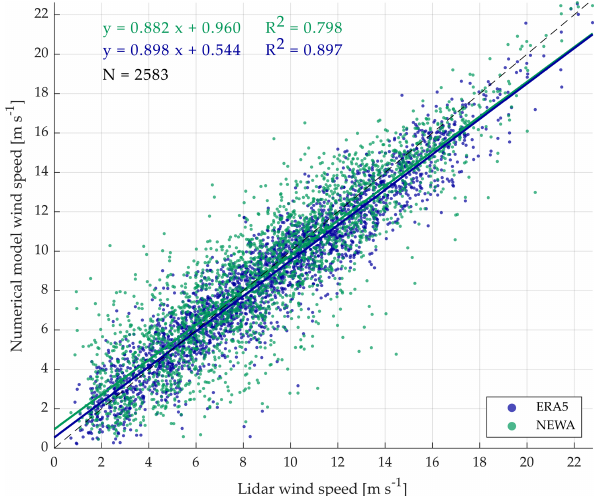
Figure 5. Scatter plot of wind speeds measurements at 100m from lidar observations and numerical models. Linear regression lines are included with corresponding colors, as well as the linear regression equations and coefficients of determination. The dashed black line represents the y = x line. N indicates the total number of data points considered in the